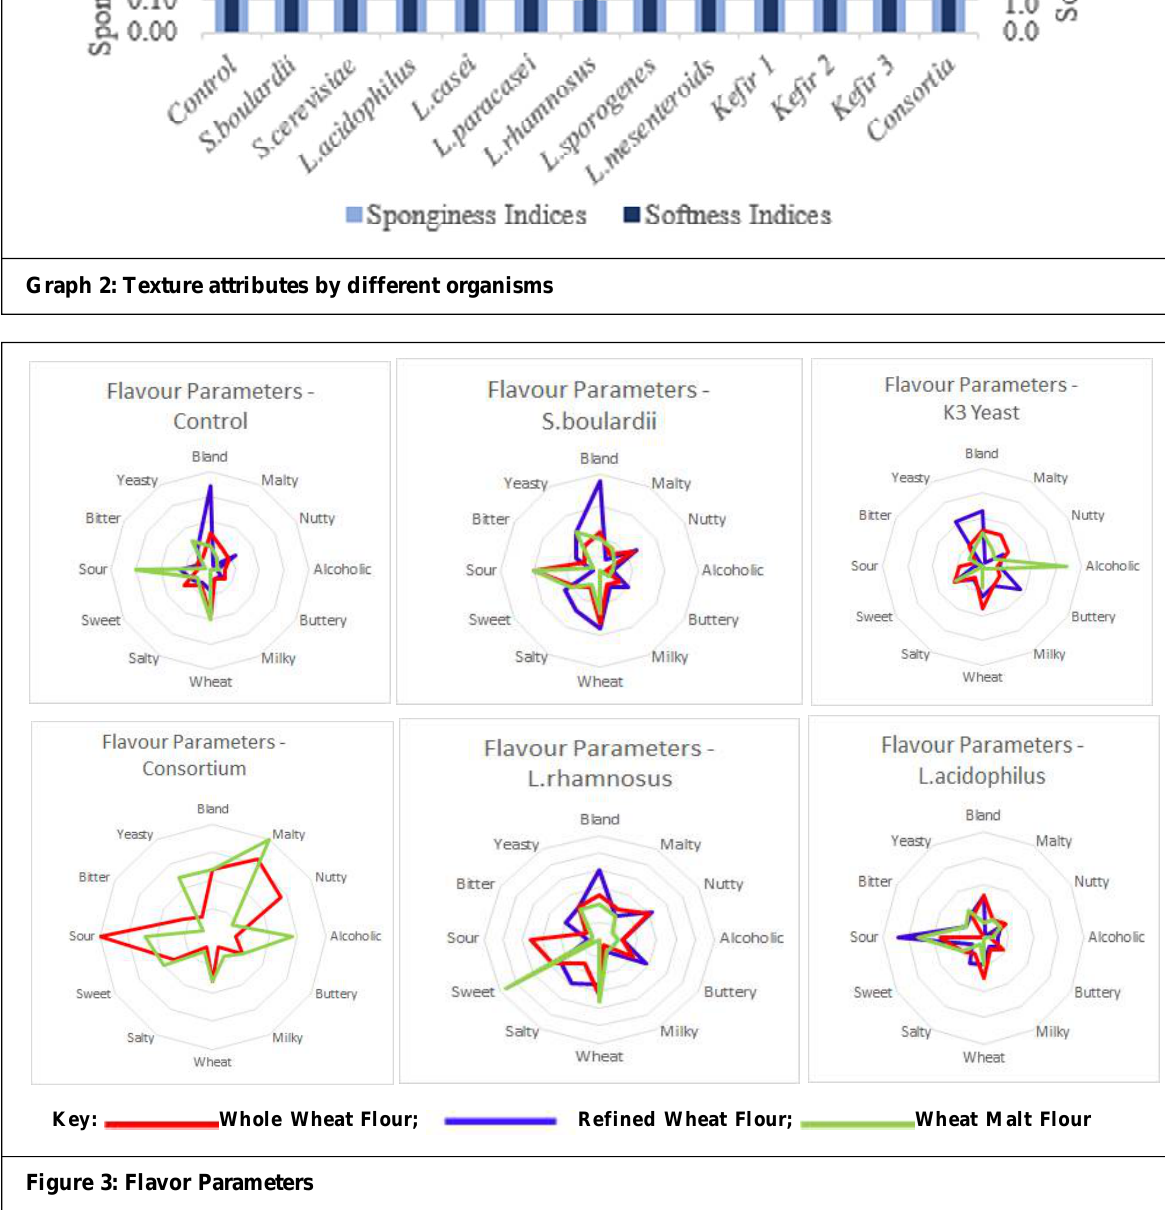
Whole Wheat Flour; Refined Wheat Flour; Wheat Malt Flour Figure 3: Flavor Parameters